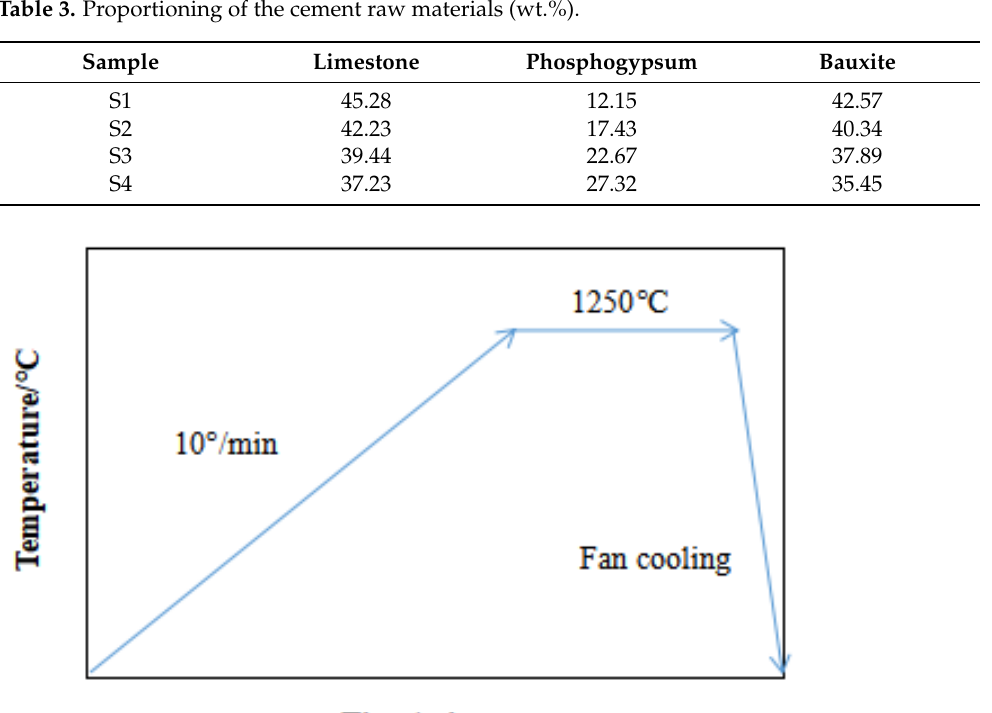
5 of 19 Table 2. Design mineral composition of cement clinker (wt.%). Sample 15 Table 3. Proportioning of the cement raw materials (wt.%).